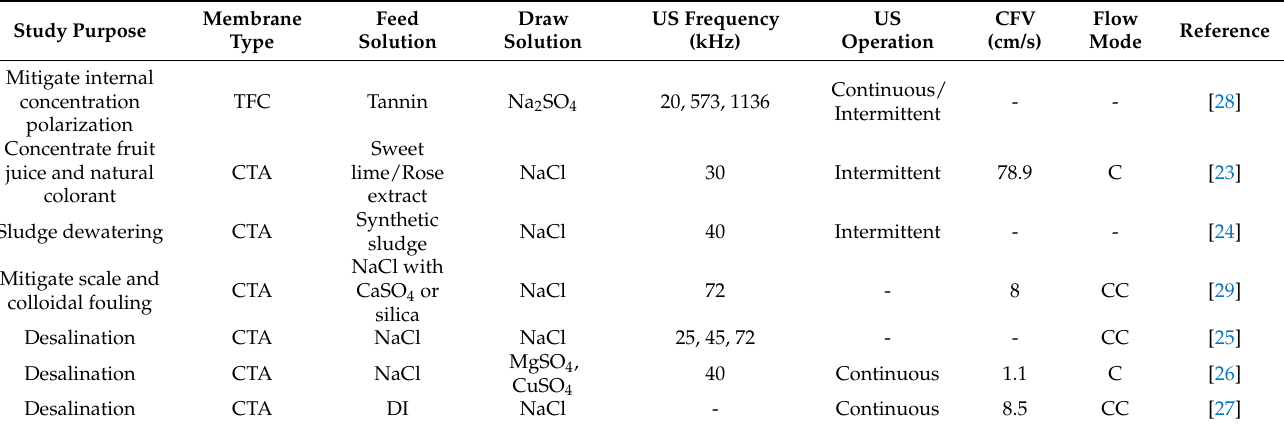
Table 1. Previous studies of ultrasound-assisted FO 1